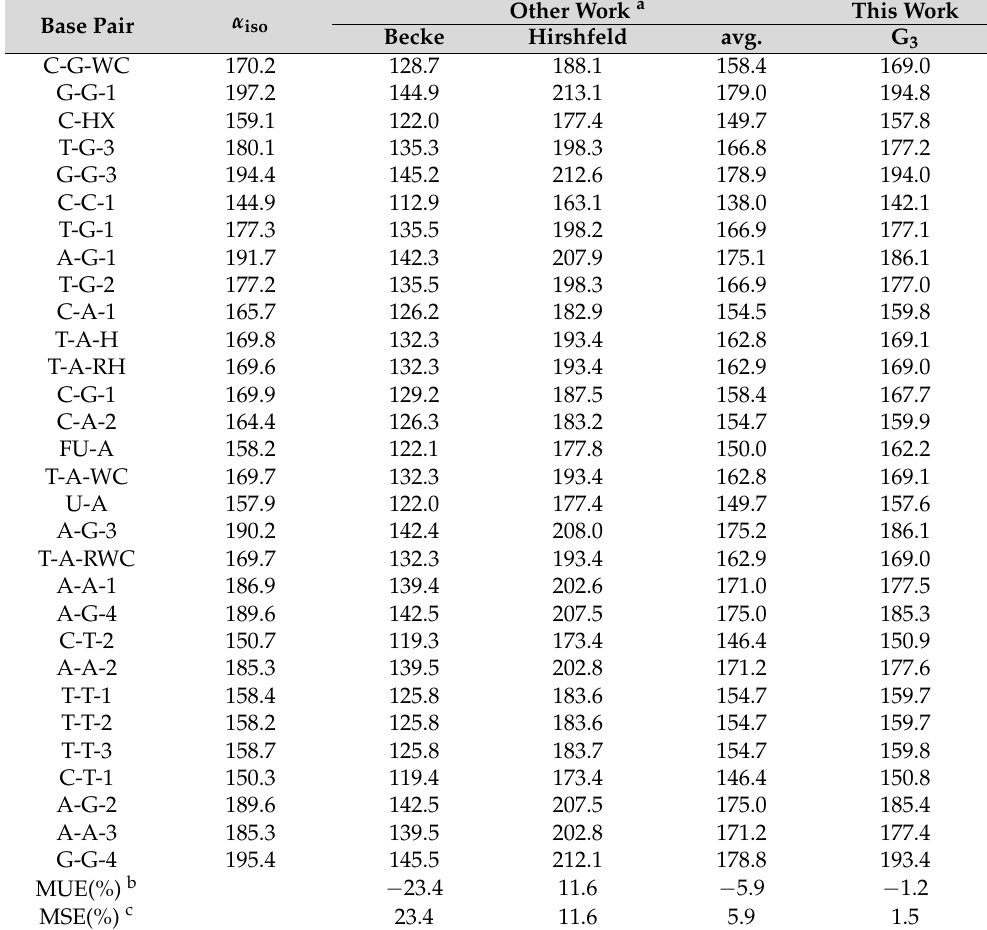
Table 4. Comparison of molecular polarizabilities ( α iso ) of 30 base pairs with conventional data as reference. Units of α iso are in Bohr 3 and G 3 is in